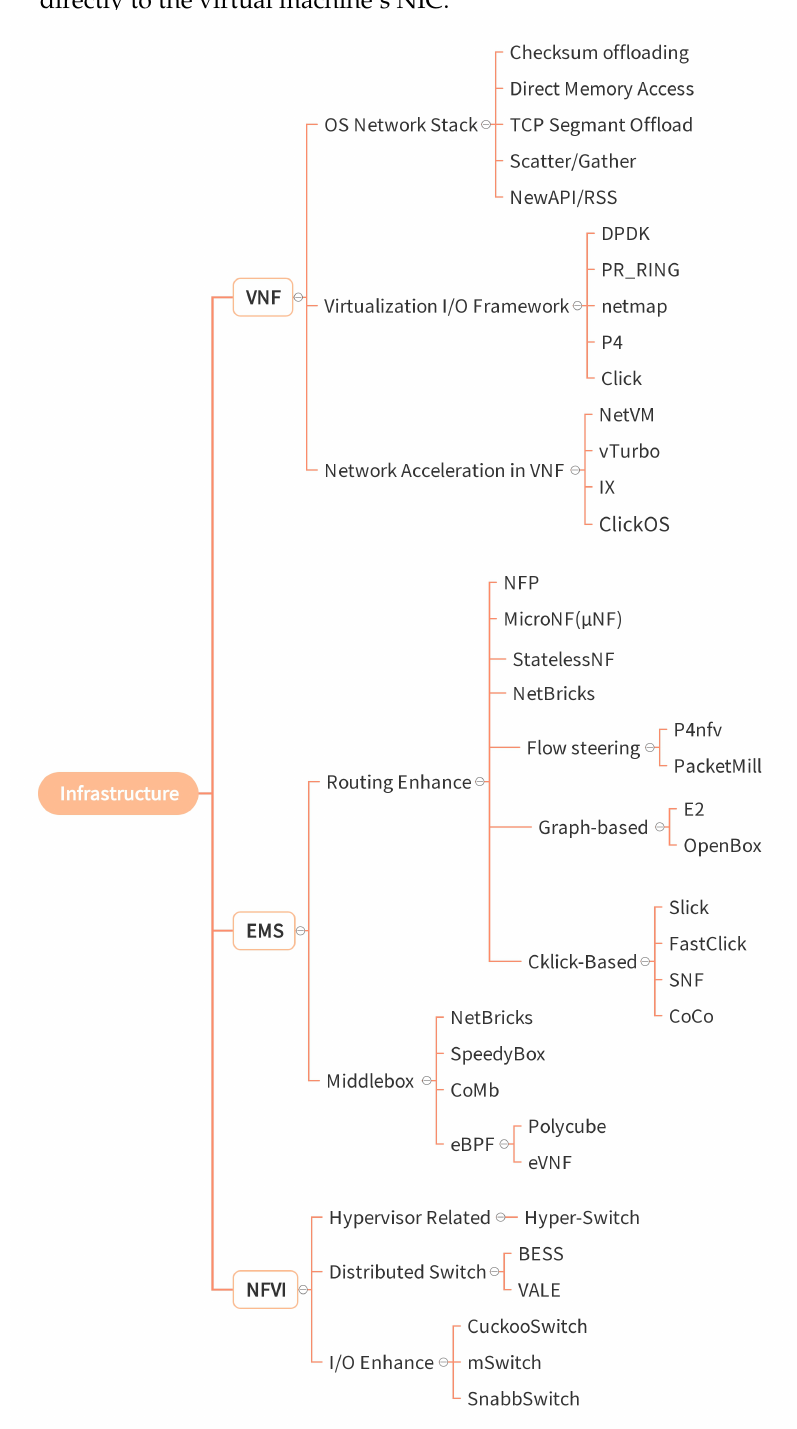
Figure 2. The accelerating solutions based on NFV